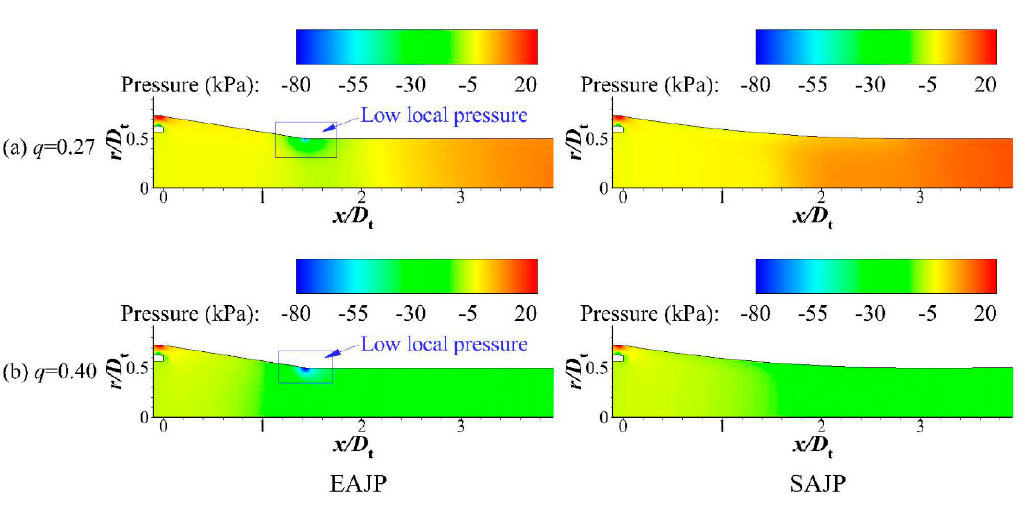
Figure 8. Pressure distribution.